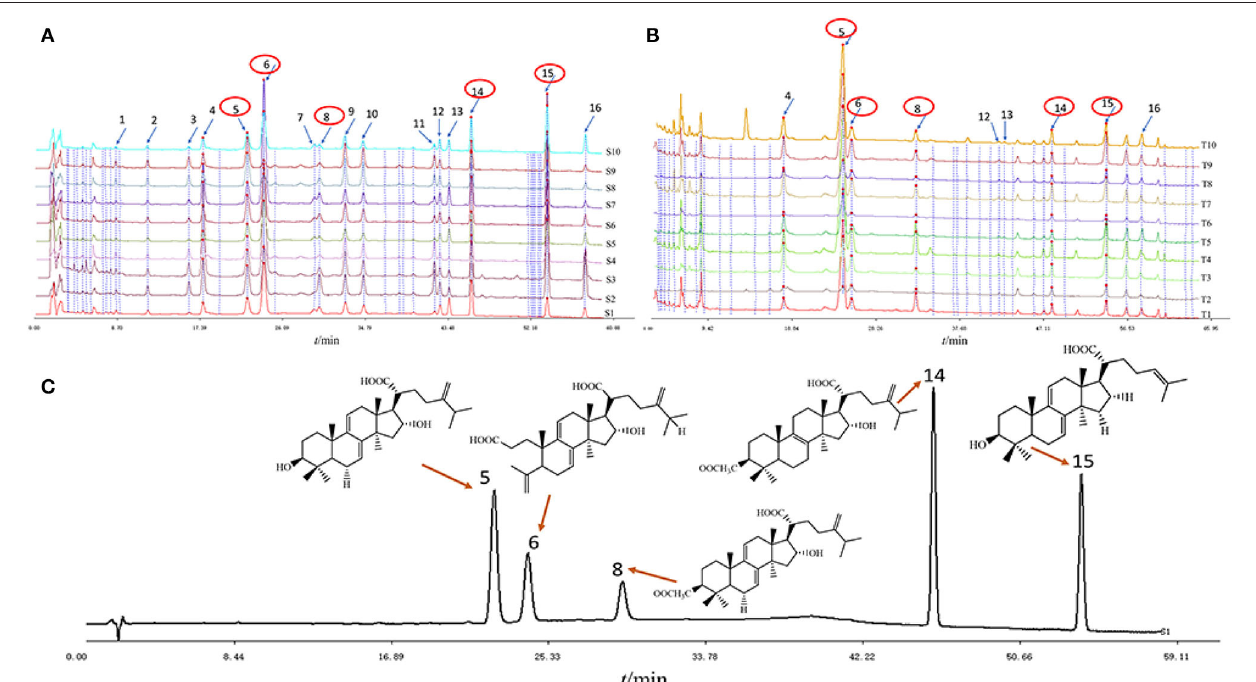
Table 2 . All parameter values were above 0.90, including the train and test sets of SNE, SPE, and ACC. These results indicated that